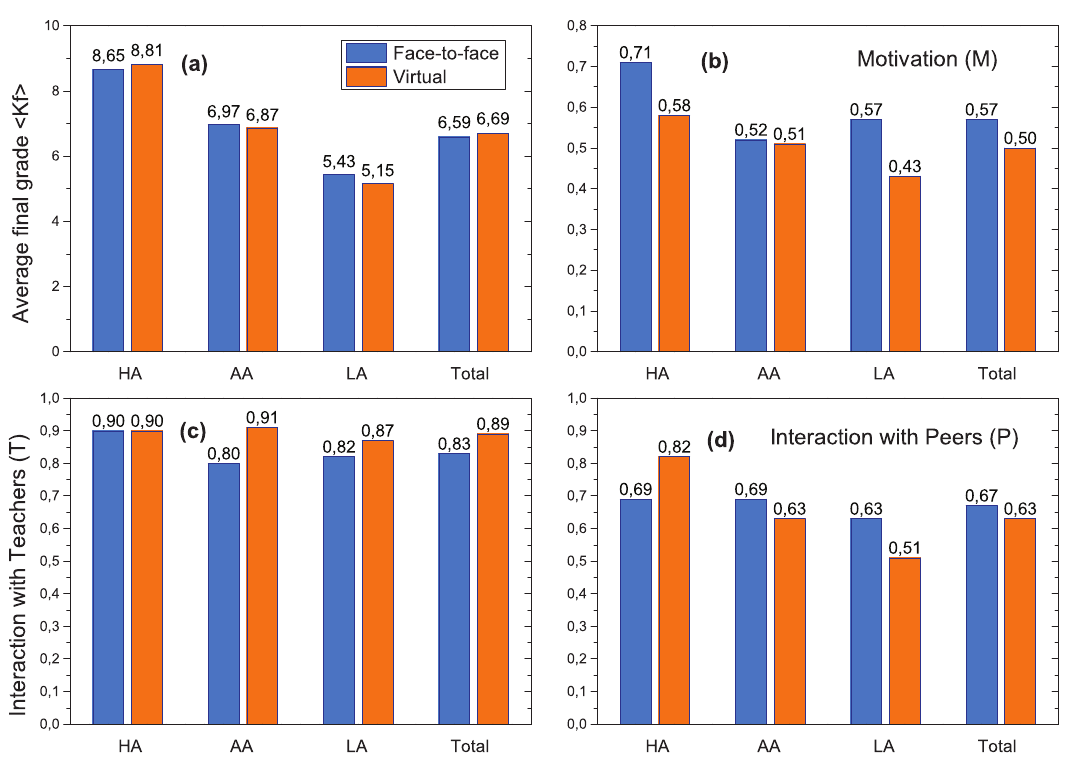
Fig 3. Numerical values associated with different quantities discriminated according to context, face-to-face (blue) and virtual (orange), averaged for each group of students HA, AA and LA. (a) Final grade < K f > , (b) motivation M , (c) interaction with teachers T and (d) interaction between peers P